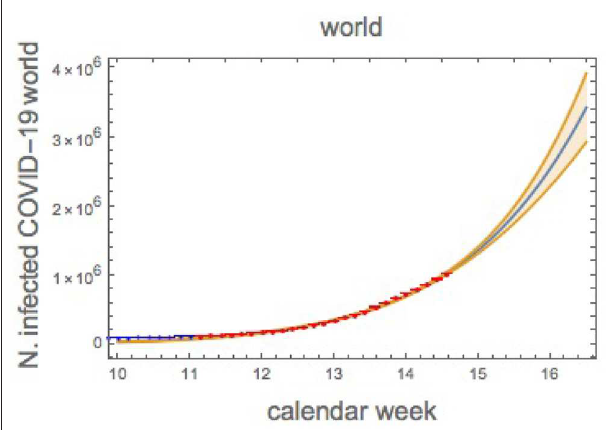
FIGURE 15 | COVID-19 infected cases for the World as function of the calendar week number. The curve and the band (90% confidence level) have been obtained by performing a fit w.r.t. a , b , and γ to the red data